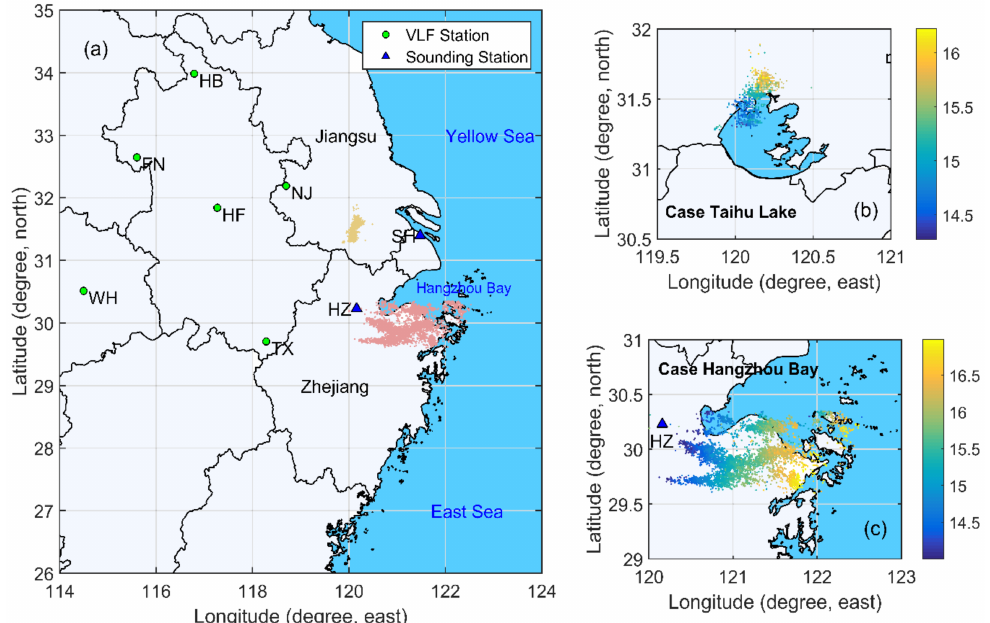
Figure 1. Location of two thunderstorms that contained outbreaks of negative NBEs when the thunderstorms were crossing over an area of open water. ( a ) The colored points represent the locations of two thunderstorms. Green dots represent locations of the lightning stations on the map. The symbols ‘ (cid:78) ’ represent locations of the sounding data stations. ( b ) Location of thunderstorm occurring above in-land Lake Taihu on 19 August 2012. The color scale represents time variations. ( c ) Location of the thunderstorm near Hangzhou Bay on 12 September